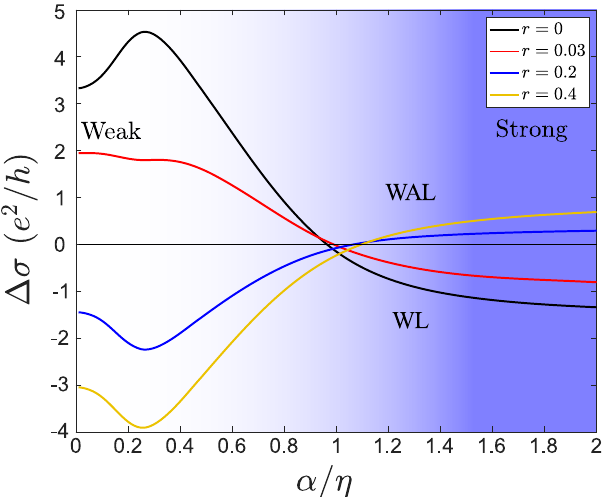
Fig. 4 Quantum corrections to the electrical conductivity. Quantum corrections to the electrical conductivity, Δ σ , as a function of Rashba coupling strength for various ratios of the intervalley and intravalley scattering rates, r = τ v / τ iv ratios (keeping η fi xed). WAL-to-WL transitions happen for ultra-clean samples ( r ≲ 0.03), whilst WL-to-WAL transitions occur in dirty samples ( r ≳ 0.2). The background colour gradient indicates the shift from the weak SOC regime to the strong SOC regime. Here we used ε = 0.2 eV, L = 1 μ m, η ≃ 1.2 meV (corresponding to a mean free path of l = v τ p ≃ 0.3 μ m, with v = 10 6 ms − 1 ) and n = 10 12 cm − 2 for the Fermi energy, linear length, quasiparticle broadening, and impurity density respectively, whilst also assuming that u x = u y (with η fi xed) for the intervalley scattering